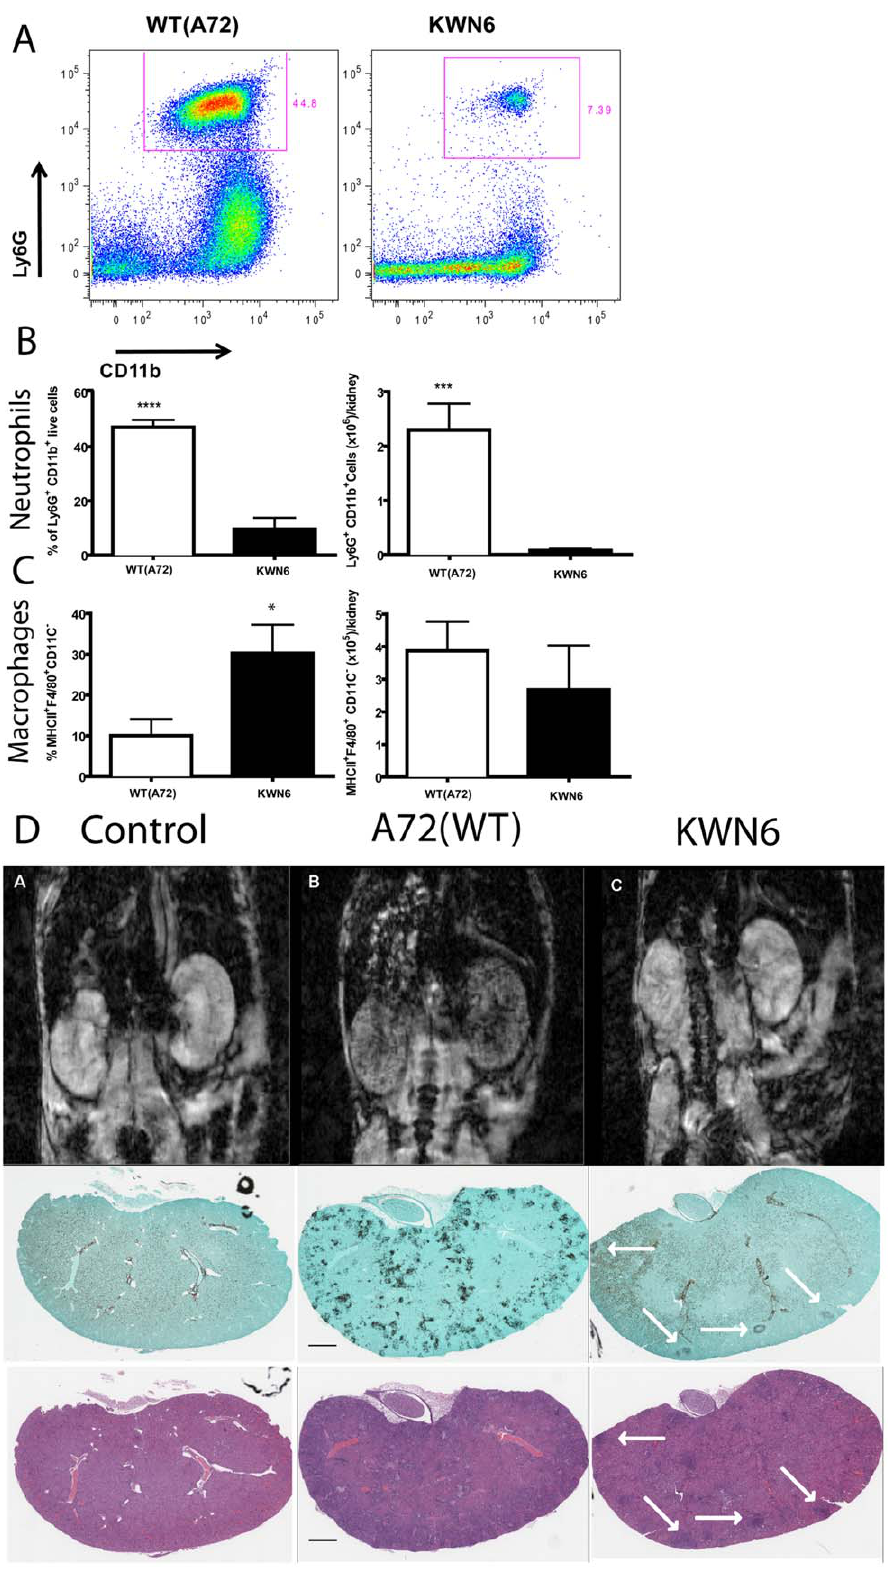
Figure 4. Dur1,2p expression increases inflammatory cell infiltration in infected kidneys. A. Representative FACS plots of kidney neutrophils at day 3 PI with WT and KWN6. B Neutrophils expressed as percent of CD45 + cells (left panel) and as absolute numbers per kidney (right). C . Macrophages expressed as percent of CD45 + cells (left panel) and as absolute numbers per kidney (right). D . Top panels show transverse MR images of 8 week old BALB/c mice 24 h post injection of USPIO agent. Images are representative of at least three non-infected mice per group (left